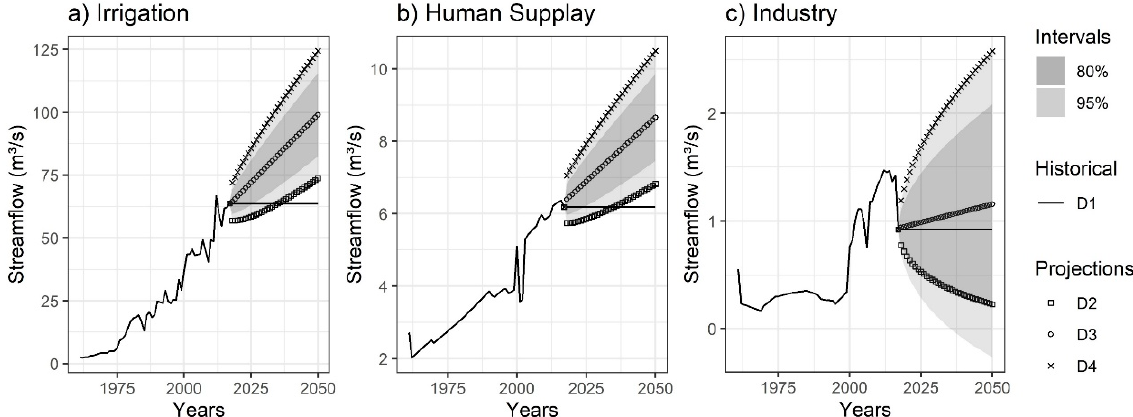
Figure 12. Scenarios of the projections of annual consumptive demands on the Itaparica reservoir using the ETS model for the period 2018 to 2050.